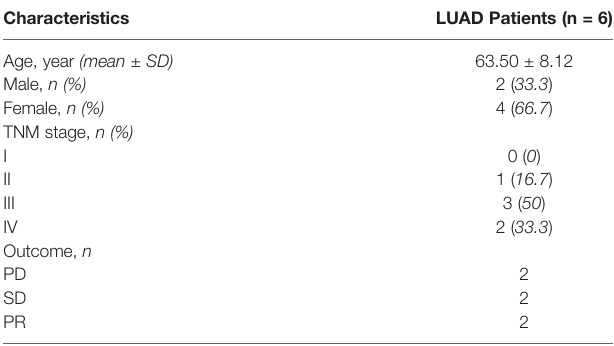
TABLE 1 | The summary clinical information of the samples.